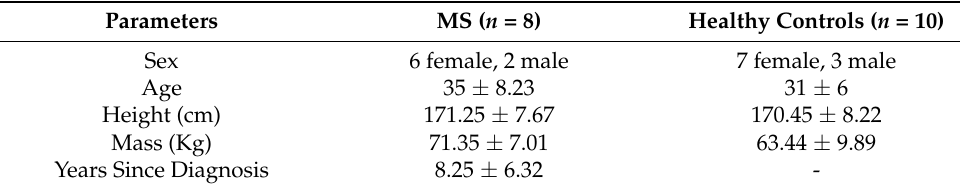
Table 1. Demographic information for MS patients and healthy